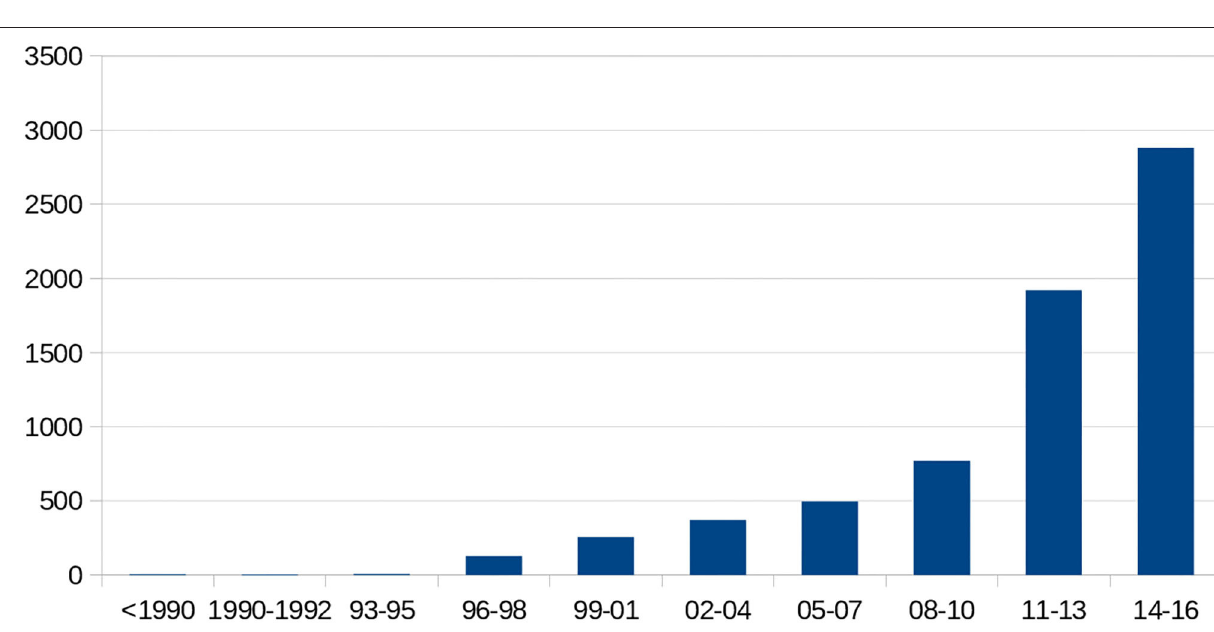
FIGURE 2 | Temporal evolution of number of alloimmunization.